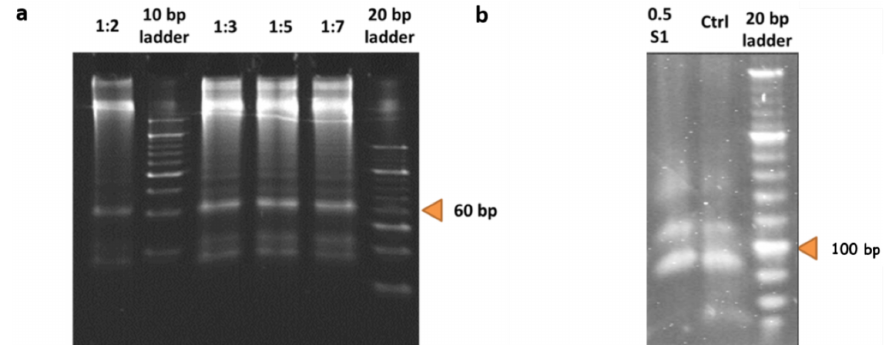
Figure 7. In vitro experimental results ( a ) Free-order hyperedge production. The 10 bp and 20 bp ladders were added in lanes 2 and 6. The ratio between primers and variable DNA sequences were varied to see if there was any effect on the length of the hyperedges produced. ( b ) The control lane shows from 70 base pairs up, perfect, 1, 2, 3-mismatched sequences. The perfectly matched DNA at 70 bp, 1-mismatch at 90 bp, 2-mismatched at 110 bp and 3-mismatched at 130 bp. Lane 1 contains the sample with S1 nuclease treatment. The perfectly matched DNA strands in the lower most